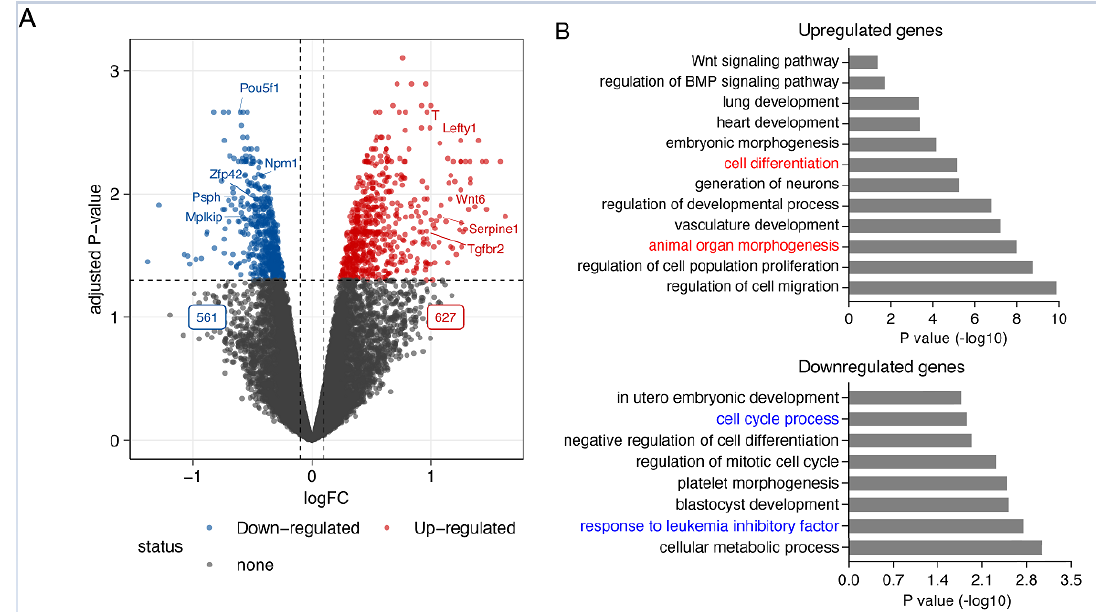
Figure 1. Smad7 regulates the expression of the genes involved in pluripotency maintenance and self ‐ renewal in ESCs. ( A ) Volcano plot showing the 1188 differentially expressed genes. Significantly differentially expressed genes in response to Smad7 KD (FDR < 0.05 and log2 fold change > 0.2) are indicated in red and blue. While 627 genes are upregulated, 561 genes are downregulated. The dashed line indicates the p ‐ value significance threshold. Four biological replicates were used for this analysis. ( B ) Bar graph representing the enriched GO terms of biological processes in upregulated and downregulated genes after the KD of Smad7.